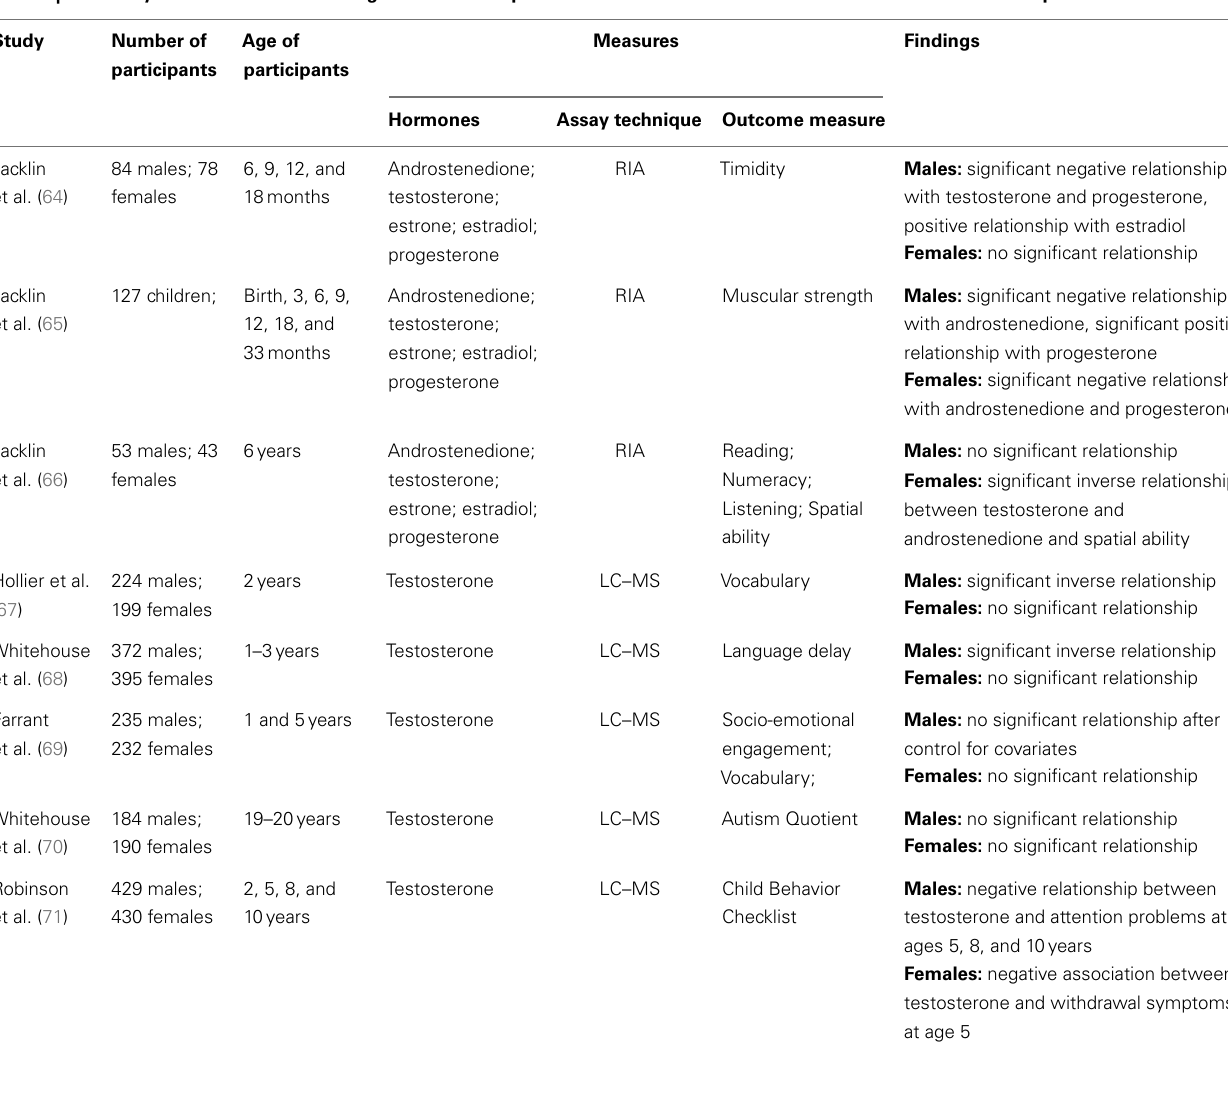
Table 1 | Summary of the studies examining the relationship between cord hormone concentrations and human development